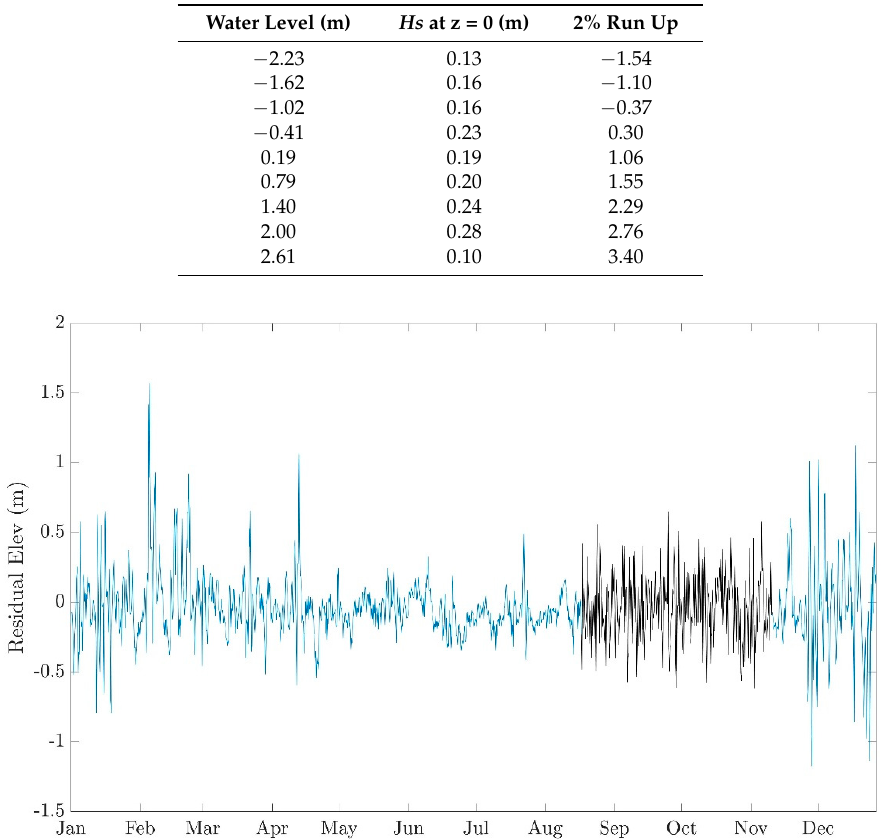
Figure A1. Calculated wave height at breaking, H b , along the undefended coastline using CSHORE propagation module and linear wave theory as in the COVE model. The northern end refers to the limit of the un-defended coastline. Table A4. Water levels, significant wave height at the shore (z = 0) and 2% run up above z = 0 CSHORE simulated results along the transect shown in Figure 13c and assuming offshore waves Hs = 1 m, Tp = 5 s, and normal to the coast incident angle.